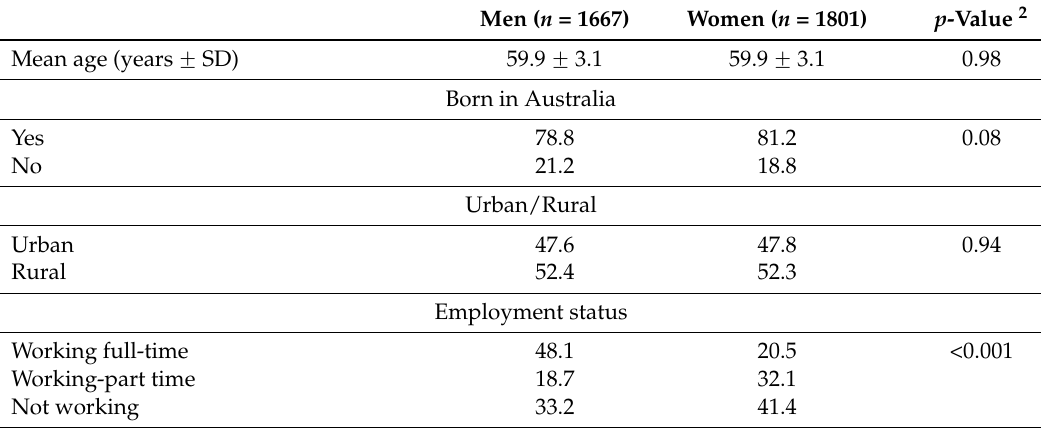
Table 2. Sociodemographic characteristics, health-related behaviours and body mass index (BMI) of the participants of the Wellbeing Eating and Exercise for a Long Life study in 2010 1